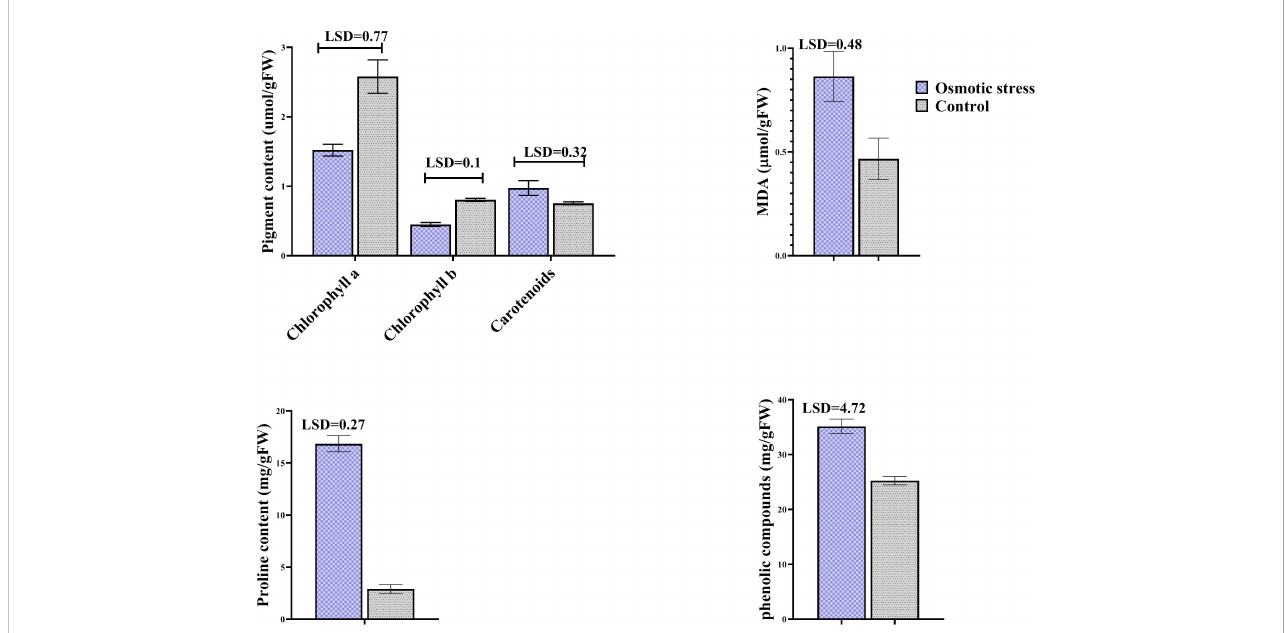
FIGURE 1 The effect of osmotic stress on photosynthetic pigments, MDA, proline and phenolic compounds in leaves of pistachio under osmotic stress compared with control. Bars indicated the SD (n = 3). Statistic were carried out at p = 0.05 according to the t test.